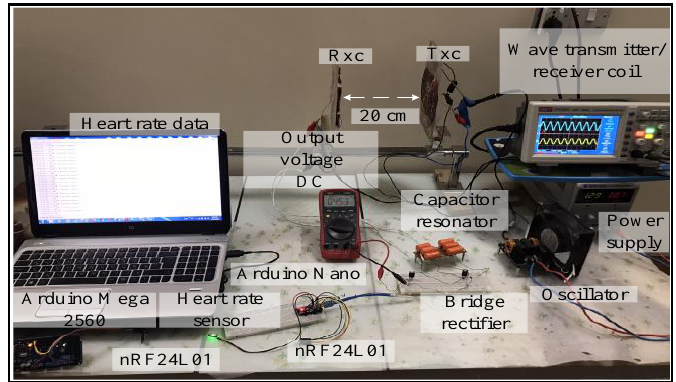
Figure 8. A snapshot of the MRC system at 20 cm for the third topology.